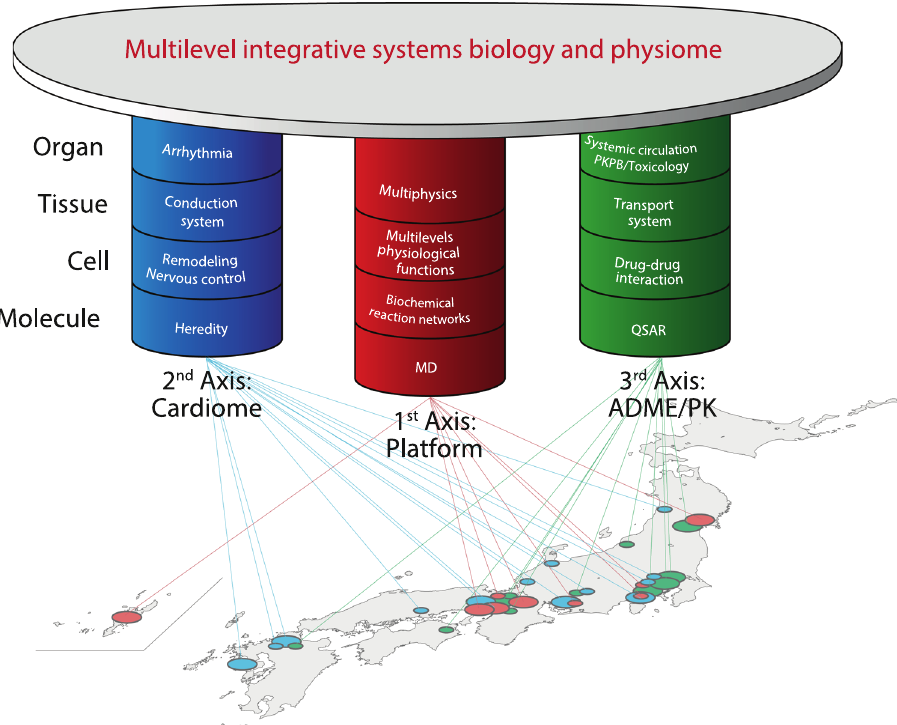
Fig. 1 The HD Physiology Project framework research platform for multilevel systems biology, cardiome, and ADME/PK is being developed to understand basic concepts of life and general mechanisms of robustness and regulation of biological networks that hold true for different types of physiological